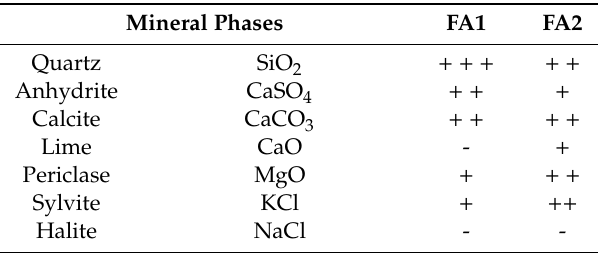
Figure 1. X-ray diffraction (XRD) patterns for fly ash FA1 and FA2. Figure 1. X-ray di ff raction (XRD) patterns for fly ash FA1 and FA2. Table 2. Mineralogical analysis (XRD) of fly ash